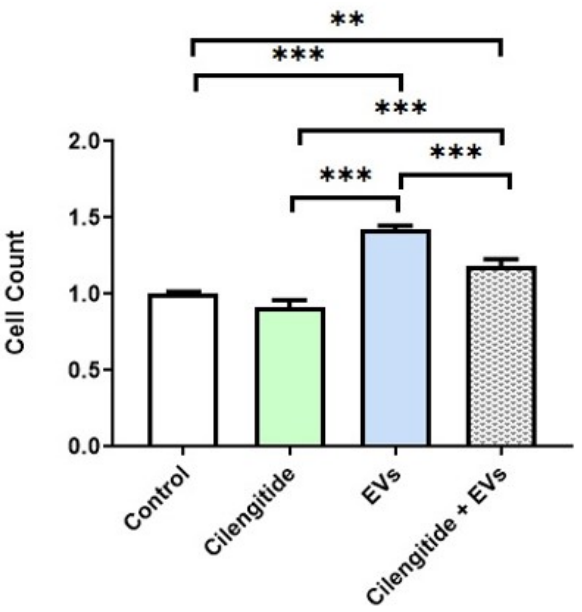
Figure 7. Inhibition of MFG-E8 receptor with cilengitide suppressed EV-induced migration of microglia. For migration experiments (see above) microglial cells were pre-treated for 30 min with inhibitor MFG-E8 receptor cilengitide (10 μ M), then treated with 1 AU of EVs. Data represents mean ± SD, ** p < 0.01, *** p < 0.001; n = 3; one-way ANOVA, Tukey’s multiple comparisons test. Lipid rafts serve as organizing platforms enriched with different signaling proteins and receptors initiating inflammatory signaling and different cellular responses [32]. We tested how EVs affect the formation of lipid rafts in microglia. Treatment of human microglia with EVs for 30 min significantly increased lipid raft formation (by 113% compared to control; n = 3; p = 0.0001) (Figure 8). Again, pretreatment with cilengitide significantly (by 44% compared to control; n = 3; p = 0.0002) suppressed EV-induced lipid raft formation (Figure 8).